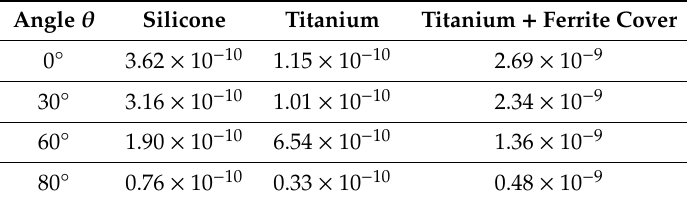
( c ) Figure 10. Equivalent circuits for series-series (SS) ( a ) and series-parallel (SP) ( b ) compensation topologies. Equivalent two-port network model ( c ). In order to generalize the analysis for any topology, the equivalent two port network representation shown in Figure 10c is considered, which is characterized by the frequency-dependent parameters A , B , C , D as: